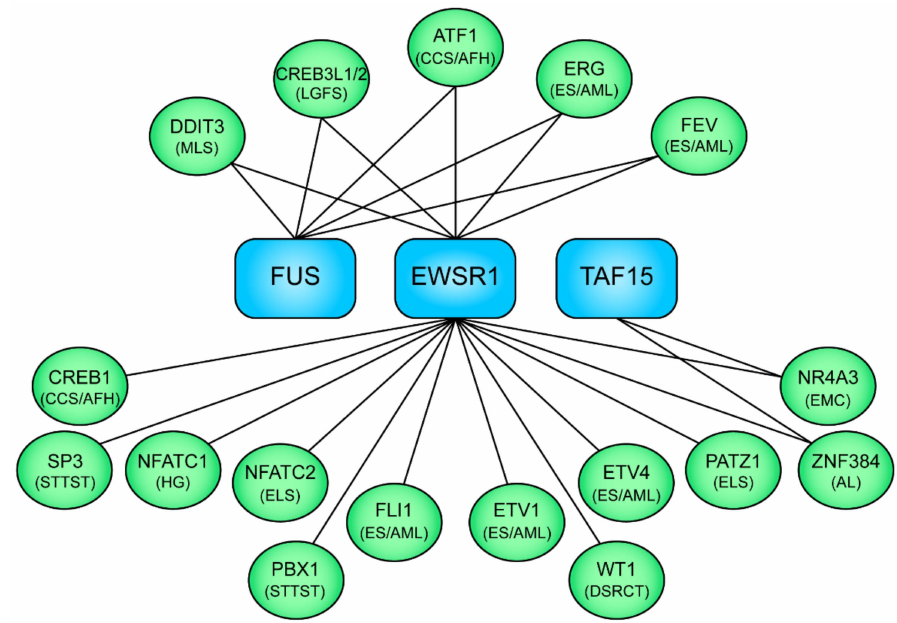
Figure 2. Schematic illustration of selected examples of the FET family of fusion oncoproteins and their associated neoplasms. The N-terminal fusion partners EWSR1, FUS, and TAF15 are shown in blue boxes, the C-terminal transcription factor fusion partners in green ovals, and the associated neoplasms in parenthesis. MLS, myxoid liposarcoma; LGFS, low-grade fibromyxoid sarcoma; CCS, clear cell sarcoma; AFH, angiomatoid fibrous histiocytoma; ES, Ewing sarcoma; AML, acute myeloid leukemia; STTST, soft tissue tumor special type; HG, hemangioma (bone); ELS, Ewing-like sarcoma; DSRCT, desmoplastic small round cell tumor; EMC, extraskeletal myxoid chondrosarcoma; AL, acute